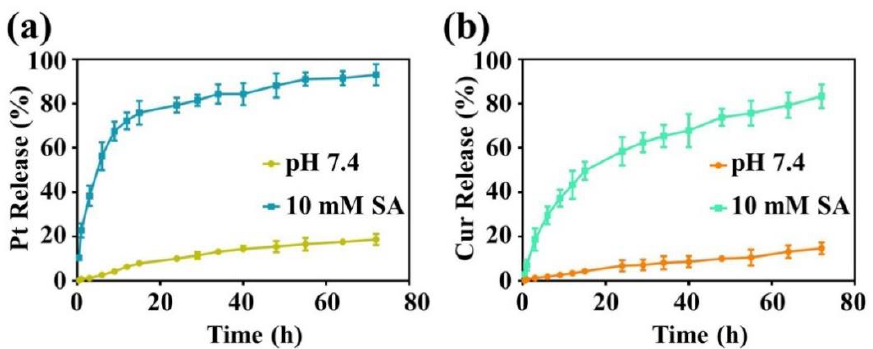
Figure 4. ( a ) Release profiles of Pt from the PCPt NPs under different conditions. ( b ) Release profiles of Cur from the PCPt NPs under different conditions.